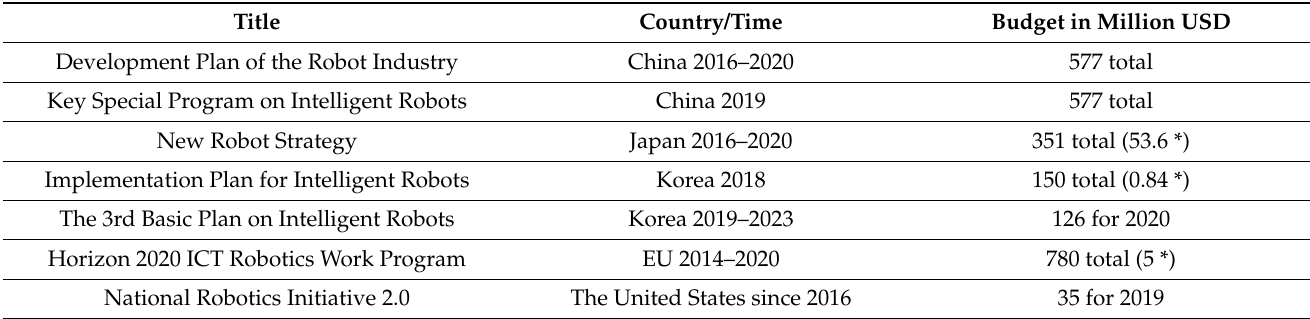
Table 2. Government initiatives for general Robotic Research & Development worldwide.